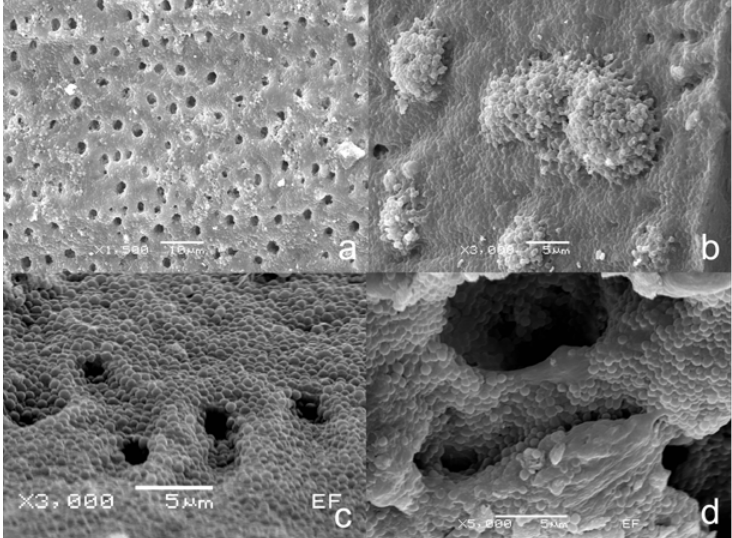
FIGURE 1- Scanning electron microscopy of (a) Various areas covered by E. faecalis biofilm on root dentinal surface (X1,500; Score #3). (b) Root dentinal surface completely covered by E. faecalis biofilm, and no dentinal tubule openings (X3,000; Score #4). (c) Evidence of root dentinal surface all covered by E. faecalis biofilm (X3,000; Score #4). (d) Bacterial penetration